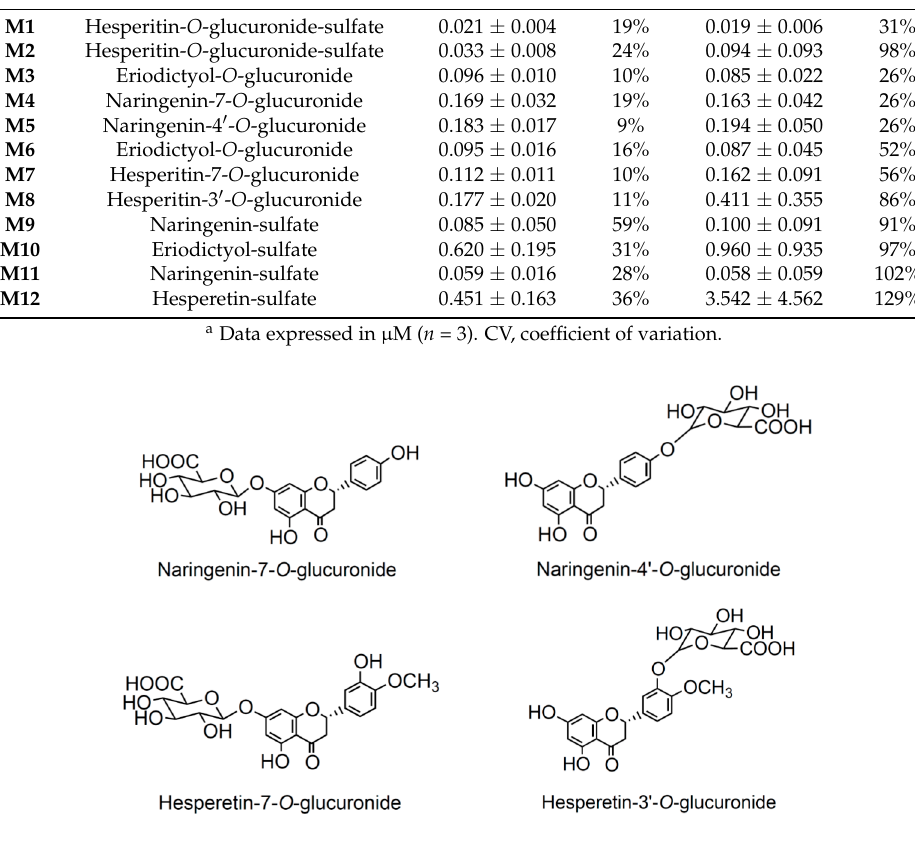
Figure 1. Molecular structures of tested compounds.